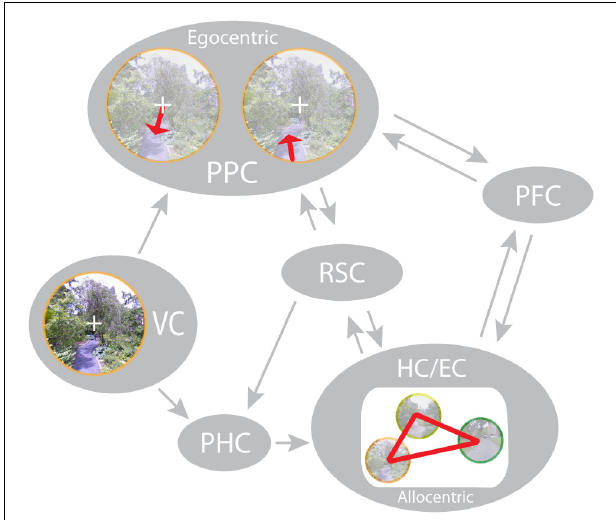
FIGURE 4 | Key regions involved in spatial memory and navigation. The PPC, situated along the dorsal visual stream, extracts spatial coordinates from visual input and translates between different egocentric reference frames (e.g., retinotopic or head-centered). These can be used to track motion and plan movements in coordination with the PFC. The PHC receives input not only via the ventral visual pathway but also from the dorsal pathway via the RSC. It projects to the HC via the EC, where allocentric coding pre-dominates. The RSC might translate between parietal egocentric and medial temporal allocentric representations. Prefrontal interactions with HC and surrounding MTL may facilitate goal-directed navigation. EC, entorhinal cortex; HC, hippocampus; MTL, medial temporal lobel; PHC, parahippocampal cortex; PPC, posterior parietal cortex; RSC, retrosplenial cortex; VC, visual